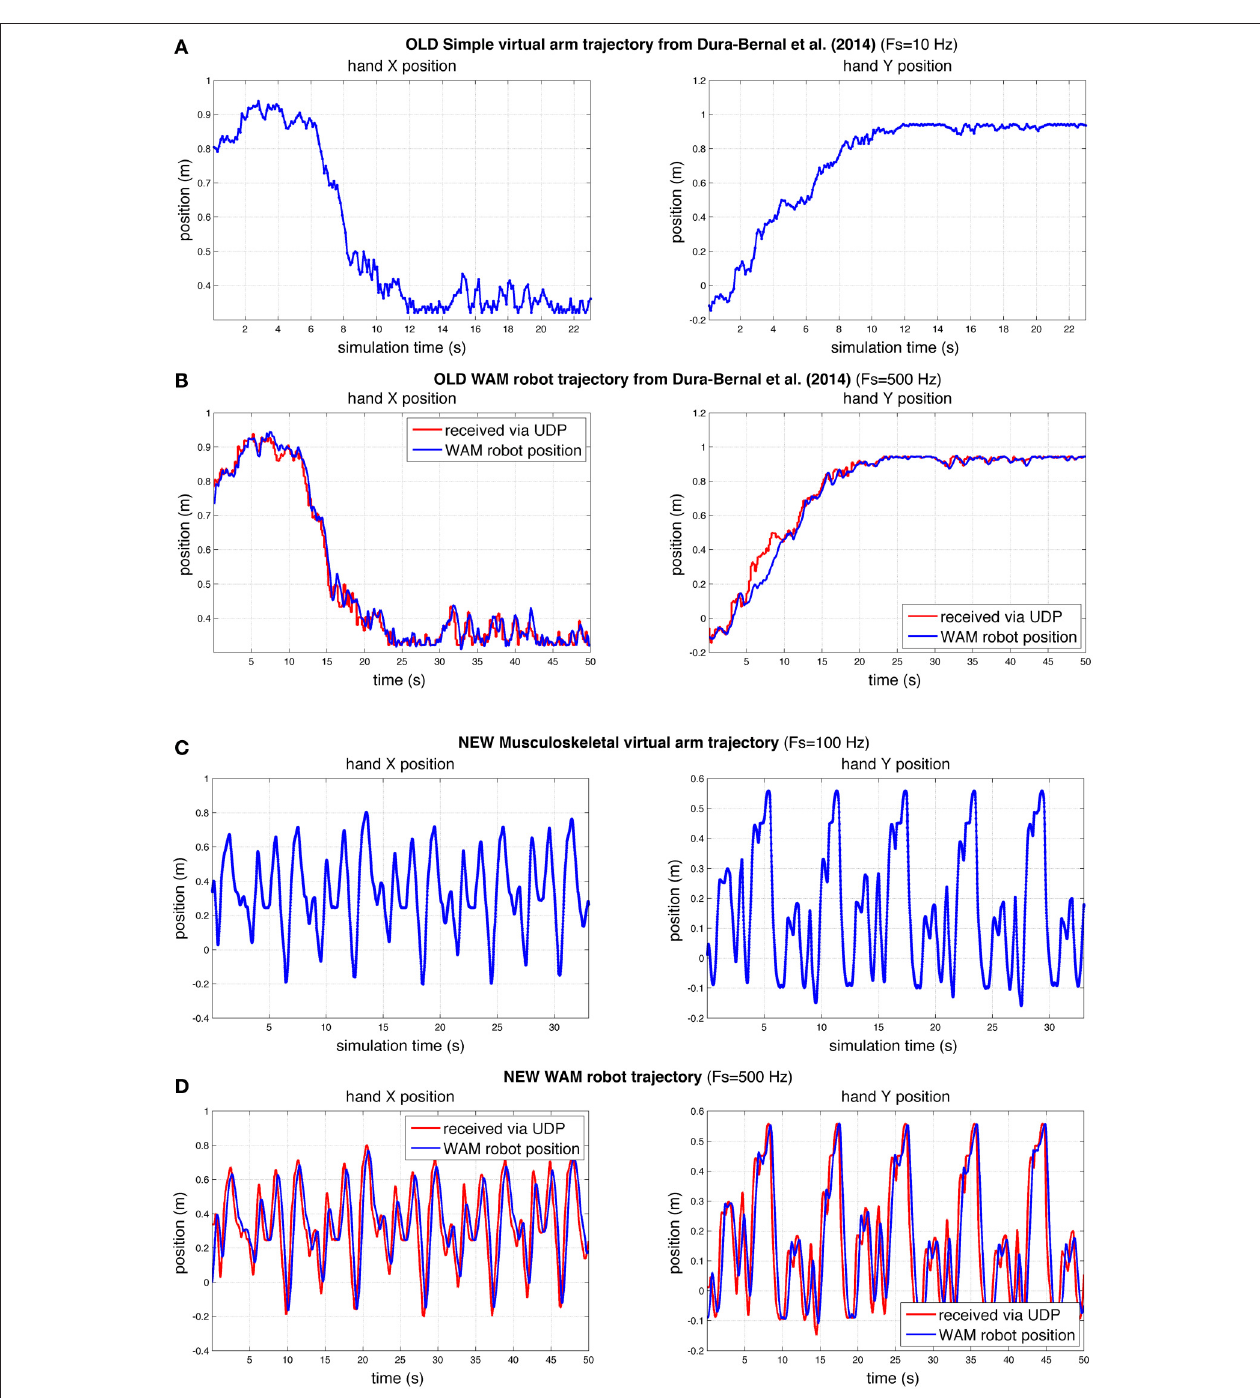
FIGURE 9 | Comparison of hand X and Y position of virtual and robot arm trajectories in our previous (Dura-Bernal et al., 2014a) and current papers. Compared to our previous paper (A,B) , here the robot arm was able to follow a more challenging trajectory in real time with a higher degree of accuracy (C,D) . The rate of update from the spiking model to the simple (A) and musculoskeletal (C) virtual arms, was 10 and 100Hz of simulated time, respectively. WAM robot arm update rate (B,D) was 500Hz; blue line represents actual robot position, whereas red line shows virtual arm trajectory received at robot arm from spiking model via network